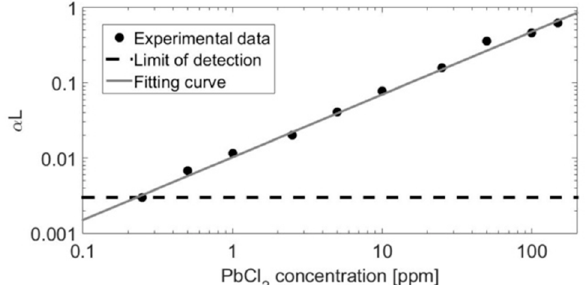
Figure 5. The CPFAAS signal as a function of PbCl 2 concentration on a log-log scale. The PbCl 2 concentration was varied by controlling the temperature of the sample container. The signal was produced by using 4 mJ and 0.1 mJ energies for the first and second fragmentation laser pulses with wavelengths of 355 nm and 266 nm, respectively. The calibration curve shows a dynamic range of 3 orders of magnitude and a limit of detection of 0.25 ppm.